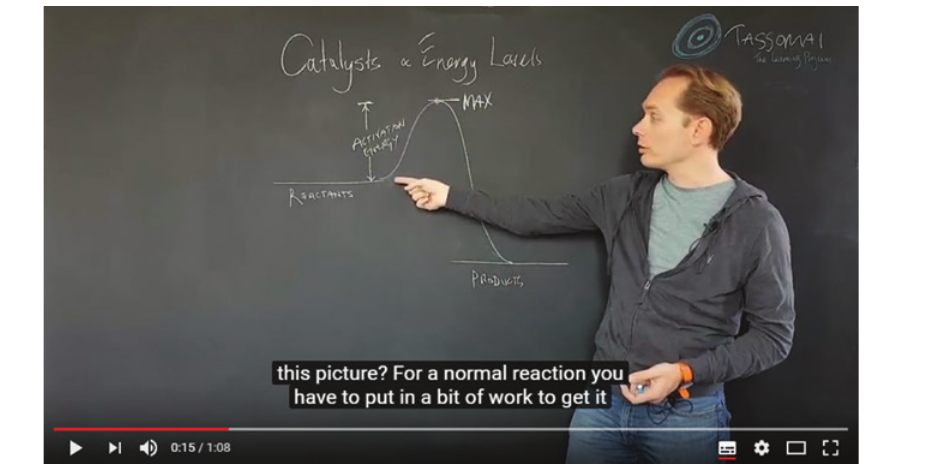
figure 1: screenshot from one of the instructive feedback videos (source: